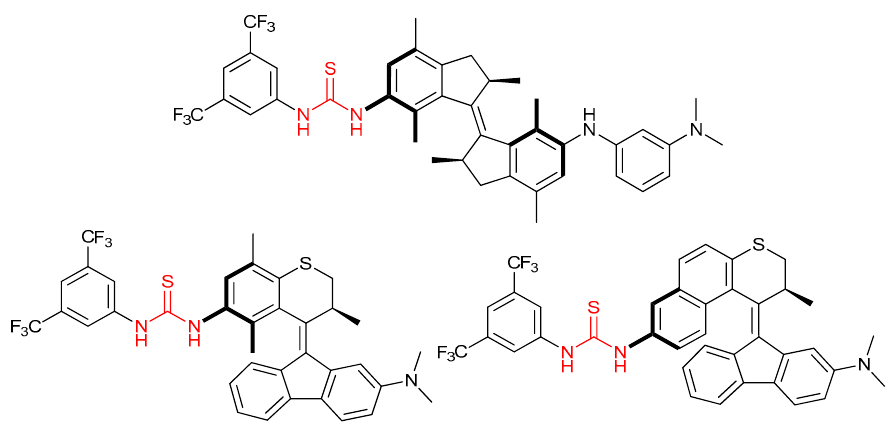
Figure 28. Molecular motors bearing thiourea moiety [330,331].